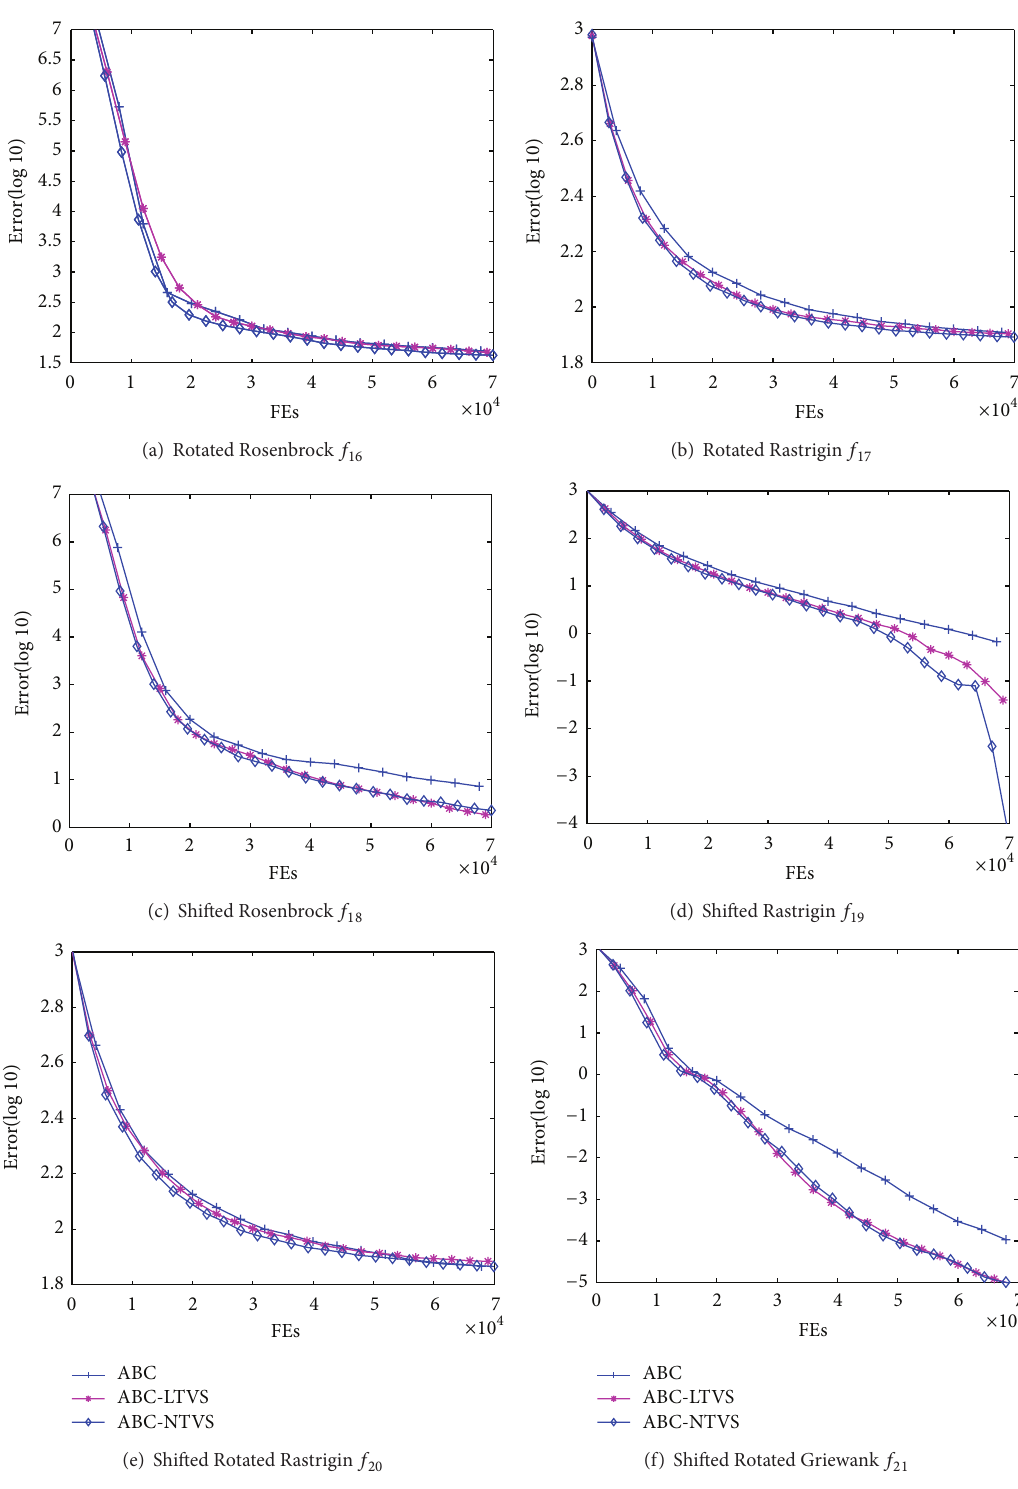
Figure 6: Convergence curves of ABC variants solving rotated and/or shifted functions 𝑓 16 – 𝑓 21